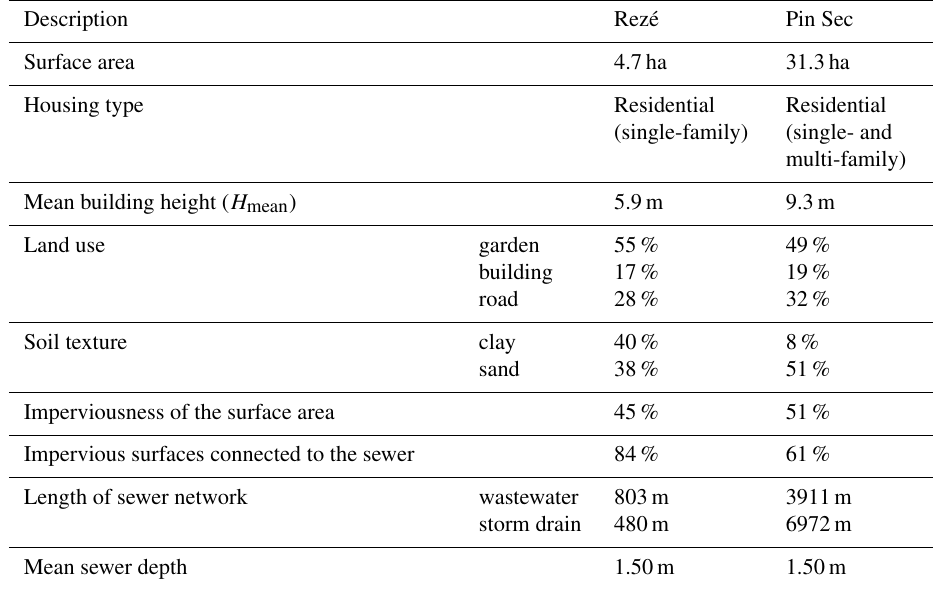
Figure 2. (a) The Rezé experimental site (from Dupont, 2001); (b) the Pin Sec experimental site. Maps to the right of the catchments indicate the location of Nantes (France) above and the Rezé and Pin Sec catchment locations (red square) in Nantes (middle). Table 1. Summary of basin characteristics for both the Rezé and Pin Sec